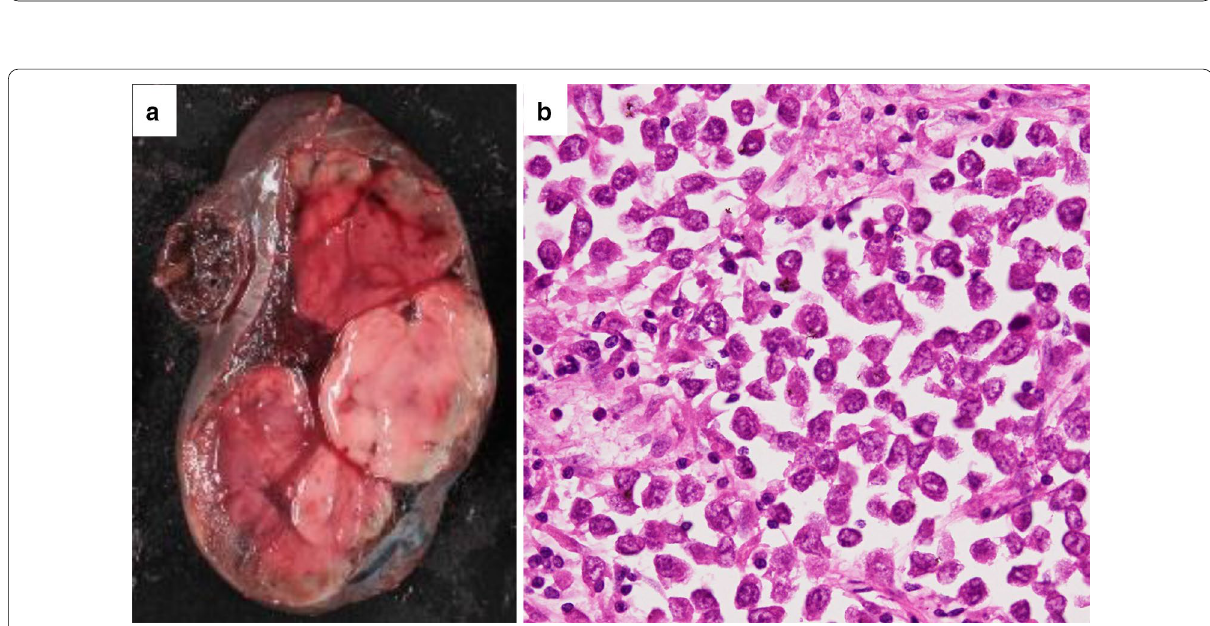
lymph node recurrence. After three cycles of chemo-